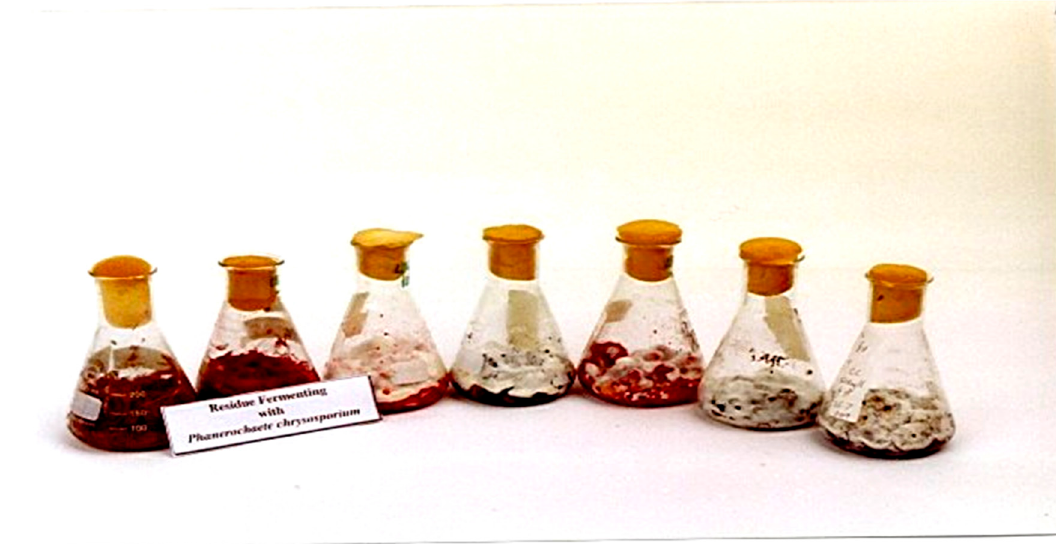
Figure 1. Recycling of agricultural residual material for textile dyes-removal from wastewater, and bioremediation using bioagents. (Picture taken by author P. Nigam from lab experiment, not published anywhere).